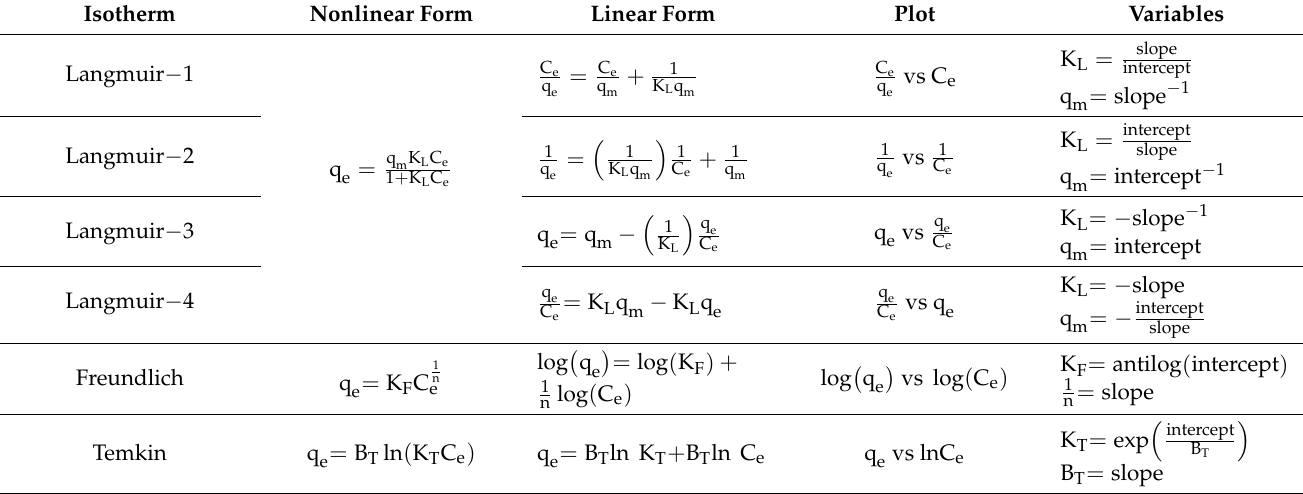
Table 3. Nonlinear and linear adsorption isotherms models used in this present